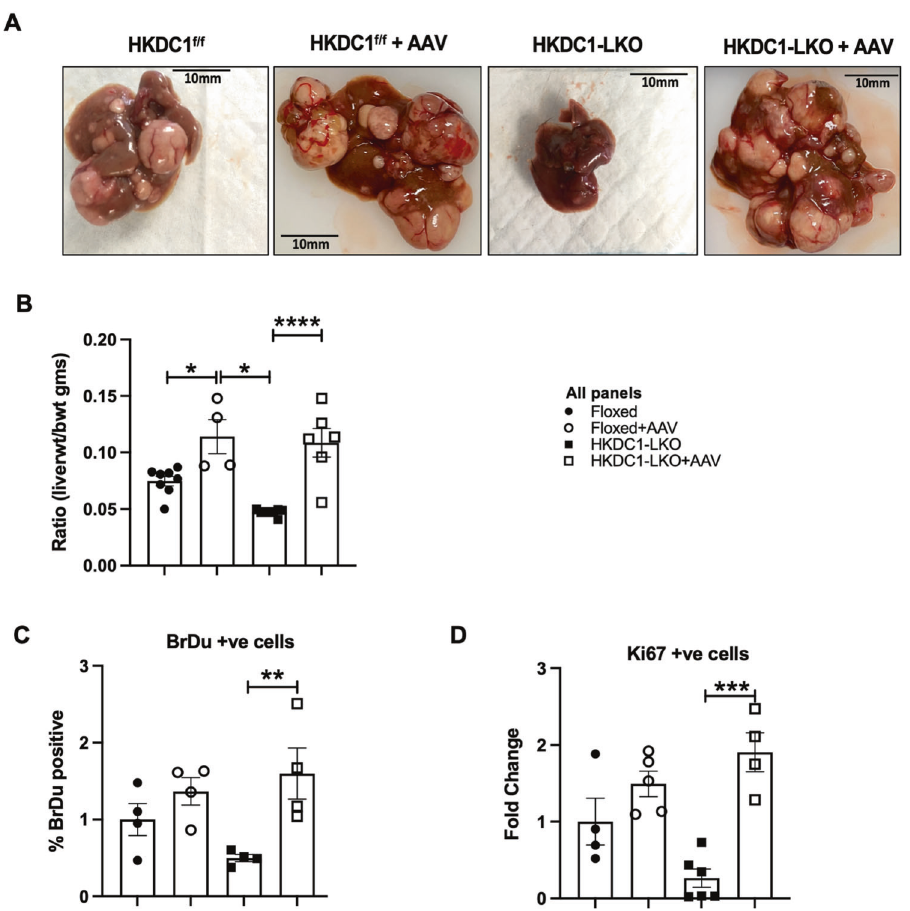
human-HKDC1 (HKDC1 f/f + AAV and HKDC1-LKO + AAV) and the AAV expressing null vector was used as the control with the two other groups (HKDC1 f/f and HKDC1-LKO), with n = 3 – 7 per group. Ten months after DEN injection, mice were sacri fi ced. A Images of the livers